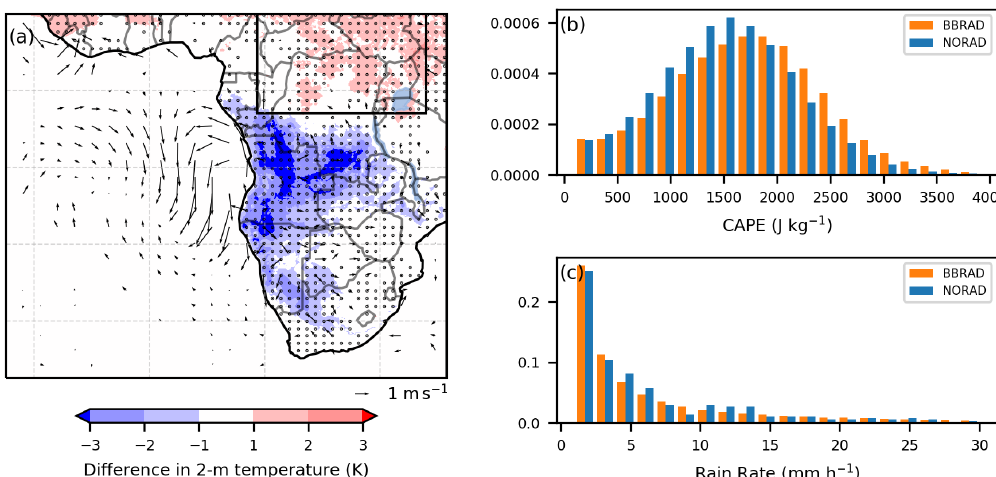
Figure 11. (a) Difference in 2m temperature (shading) and 10m wind (arrow) between BBRAD and NORAD ensemble means. Only statistically significant changes at the 0.05 level are shown for the 10m wind, while the black dots over land overlay these changes for the 2m temperature. Histogram of (b) CAPE and (c) rain rate. Fields are daily means between 8 and 16 September 2017. In panels (b) and (c) , the fields are taken from the black box over land shown in panel (a) . In panel (b) , CAPE is shown for CIN less than 1Jkg − 1 and for CAPE larger than 100Jkg − 1 . In panel (c) , the rain rate is shown for values between 1 and 30mmh − 1